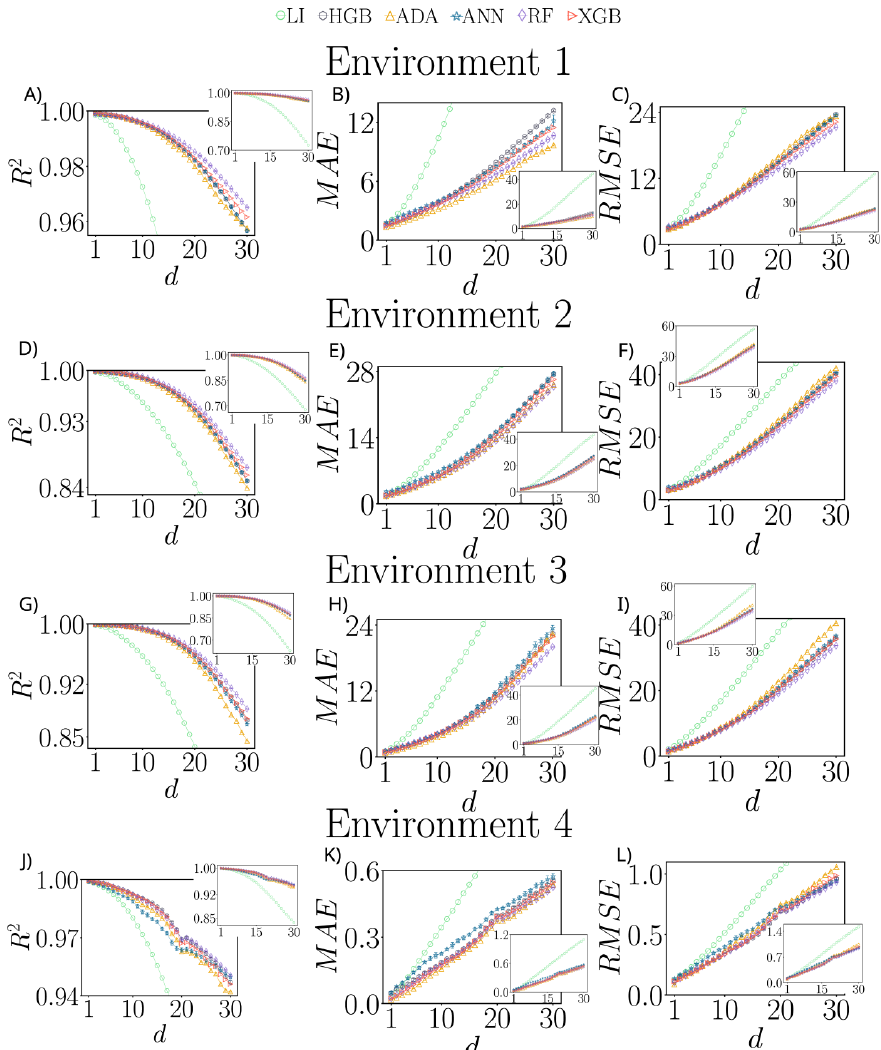
Figure 4. For each environment, three Figures are shown, each with a different metric ( Y axis) related to the variable d ( X axis). These metrics are R 2 , MAE, and RMSE. R 2 corresponds to ( A , D , G , J ). MAE corresponds to ( B , E , H , K ). And lastly the RMSE corresponds to ( C , F , I , L ). In each Figure, two scatter plots are displayed, with the same representations on the X and Y axes, the difference being only a complete view on the smaller plot and a greater focus on ML algorithms on the larger plot. The green circles, gray hexagons, yellow triangles, blue stars, purple diamonds, and orange rotated triangles match the predictions of LI, Histogram-Based Gradient Boost, Ada Boost, ANN, Random Forest, and XGBoost, respectively. The horizontal bars refer to the standard deviation, being related to each model through color. The values shown are the result of averaging the X , Y , and Z axes of Environments 1, 2, and 3 and the X and Y axes of Environment